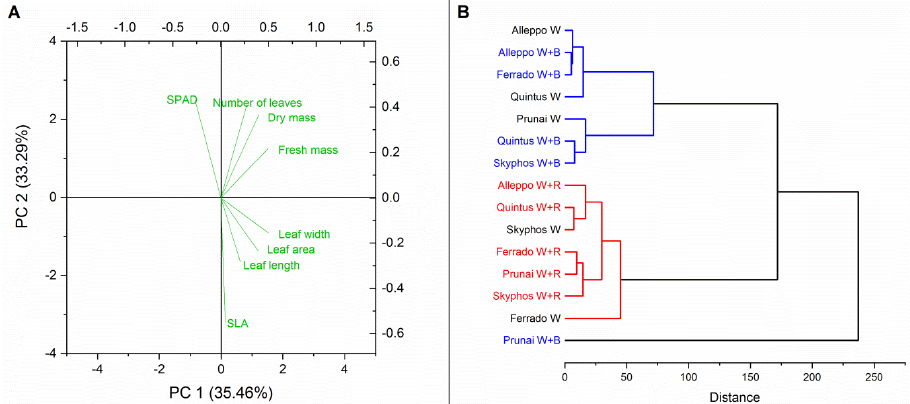
Figure 5. The principal component analysis ( A ) and hierarchical clustering ( B ) show the leaf biometric parameters in relation to the spectral composition of light.